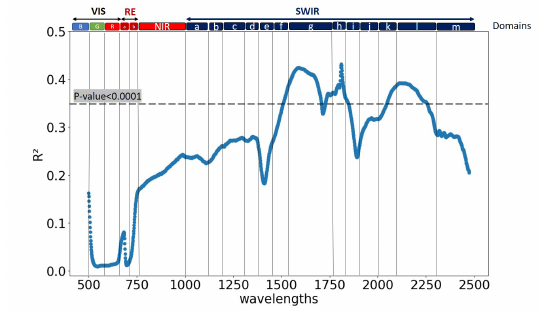
Figure 12. Determination coefficient of linear regressions for each wavelength when considering the whole database. The spectral domains defined in Table 6 are reported above the graph.